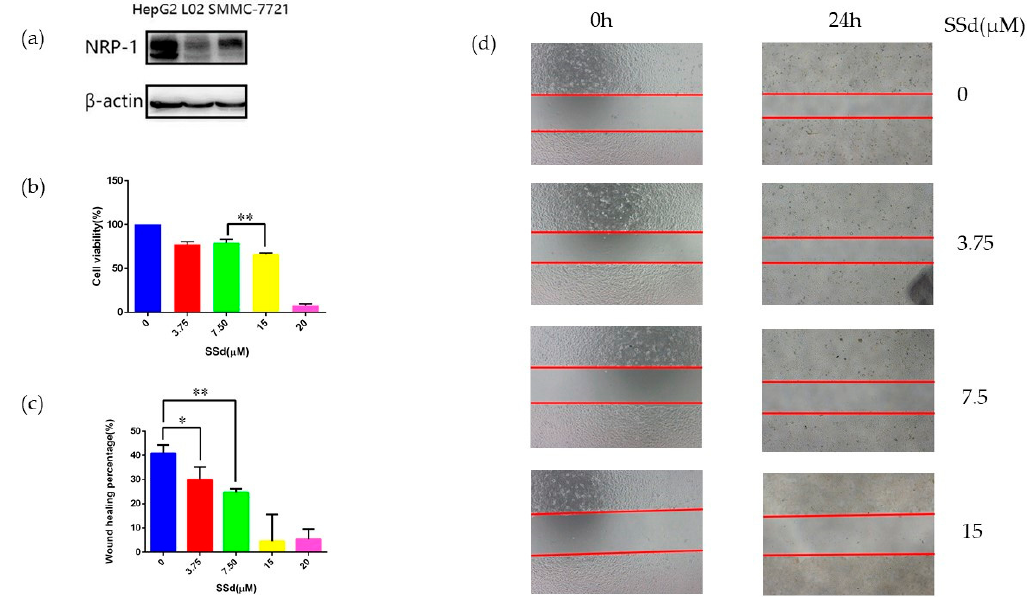
Figure 1. Cell lines comparison and the effects of SSd on HepG2. ( a ) Expression of NRP-1 in three cell lines; ( b ) cell viability of HepG2 after treatment with SSd, ** p < 0.01; ( c ) wound healing percentage of HepG2 after treatment with SSd, * p < 0.05, ** p < 0.01; ( d ) wound healing pictures of HepG2 after treatment with SSd.